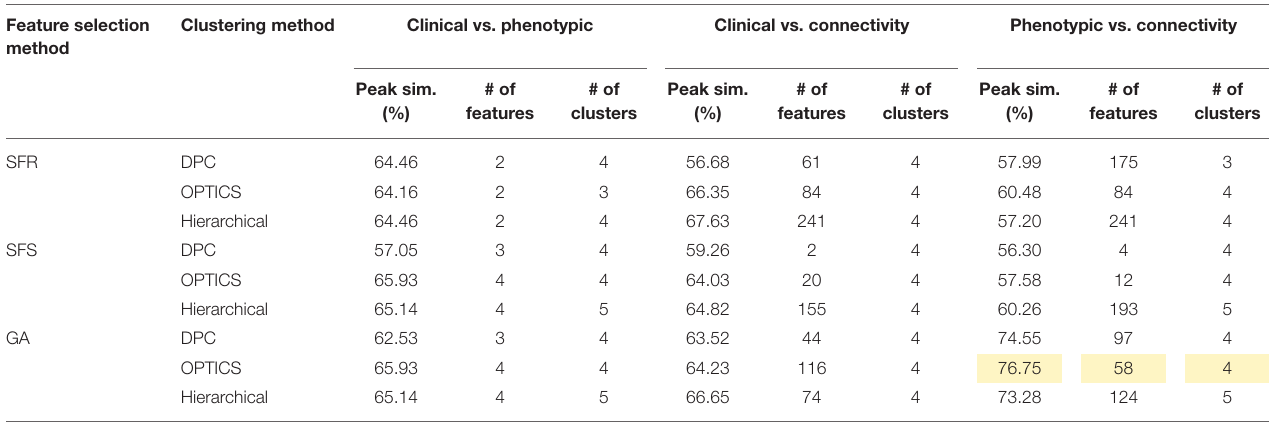
TABLE 8 | Peak similarity (highlighted), corresponding number of features, and number of clusters obtained using SFR, SFS, and GA with different clustering methods for AD dataset. Feature selection method